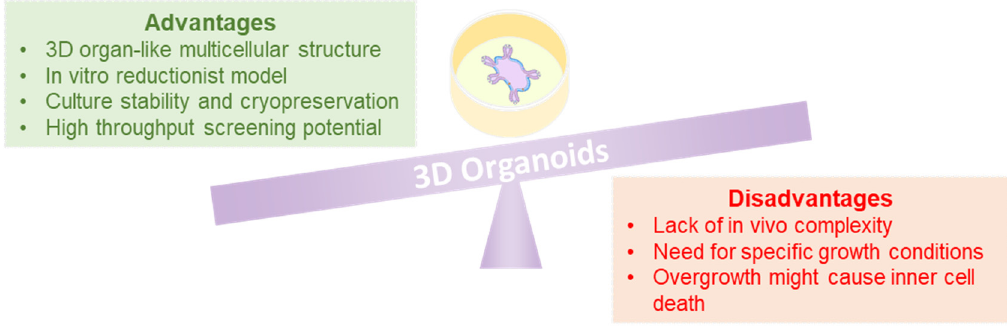
Figure 1. The balance of advantages and disadvantages of 3D organoids. As any experimental models, 3D organoids show both advantages (green box), as well as disadvantages (red box). Both sides might be taken into account when designing a study.